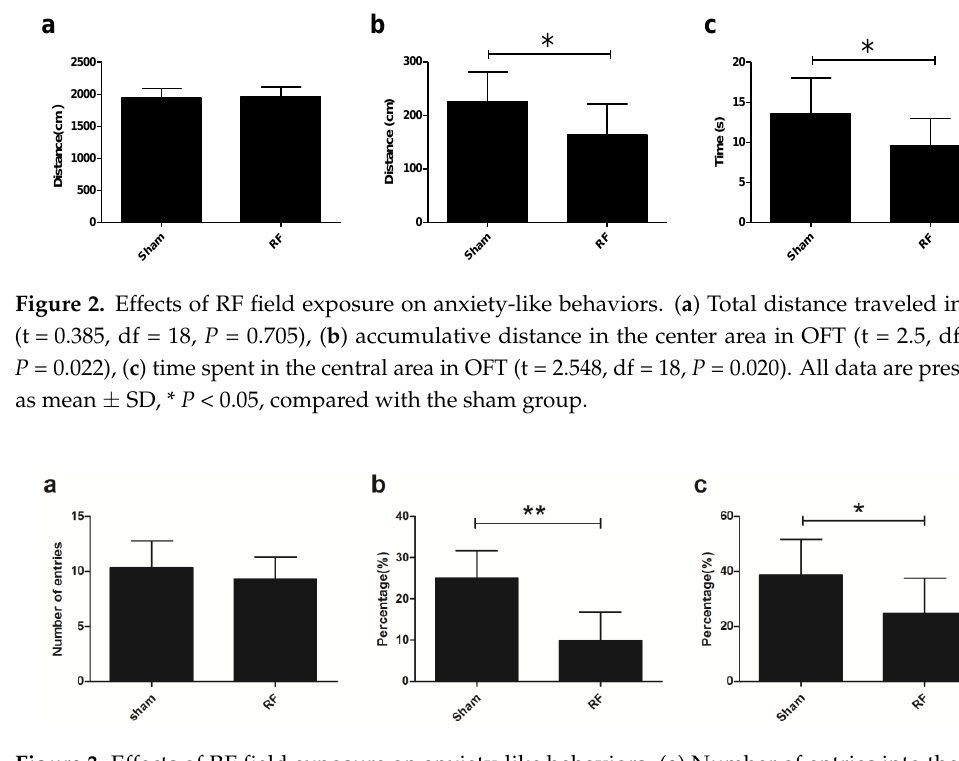
Figure 3. Effects of RF field exposure on anxiety-like behaviors. ( a ) Number of entries into the arms (open arms and closed arms) in EPM (t = 0.988, df = 18, P = 0.336), ( b ) percentage of the total time spent in the open arms in EPM (t = 5.030, df = 18, P < 0.0001), ( c ) percentage of the entries into the open arms in EPM (t = 2.411, df = 18, P = 0.027). All data are presented as mean ± SD, * P < 0.05, ** P < 0.01, compared with the sham group.